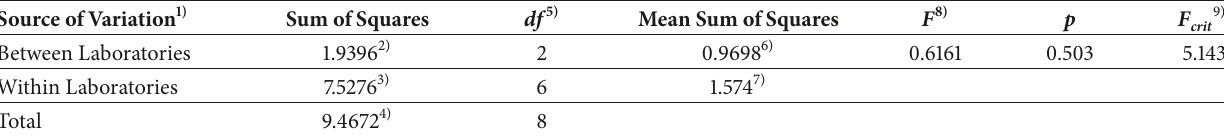
Table 3: Statistical evaluation of the inter-laboratory measurements for